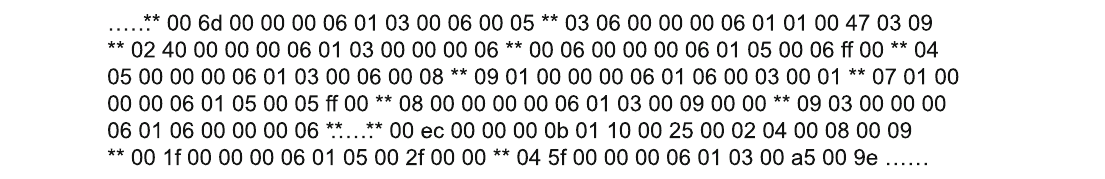
Fig. 13 The predicted results of ModbusPal. The data predicted by LSTM when the epoch is 1. The DUT is ModbusPal